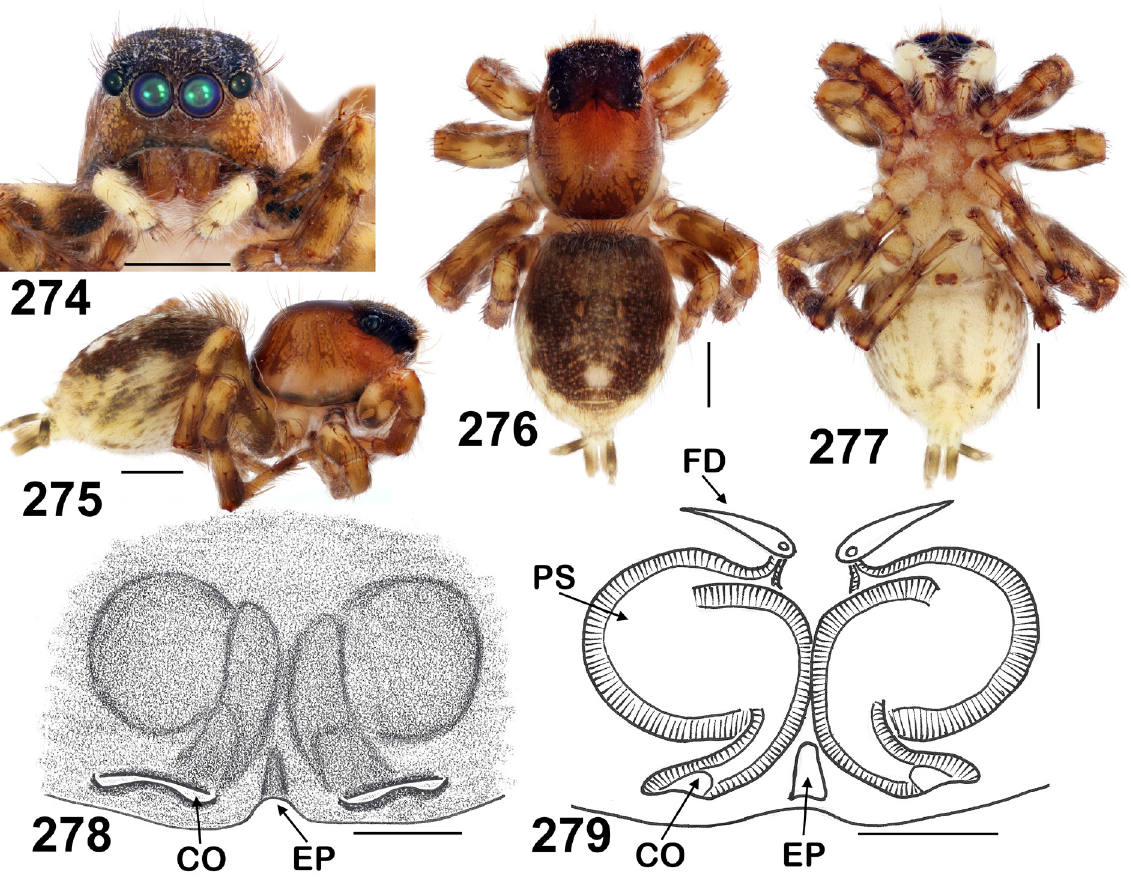
Figs 274–279. Stenaelurillus iubatus Wesołowska & Russell-Smith, 2011, ♀ (paratype of Stenaelurillus pilosus Wesołowska & Russell-Smith, 2011) from Nigeria (Ibadan) . 274–277 . General appearance. 278 . Epigyne, ventral view. 279 . Spermathecae, dorsal view. Abbreviations: see Material and methods. Scale bars: 258–261 = 1 mm; 262–263 = 0.1